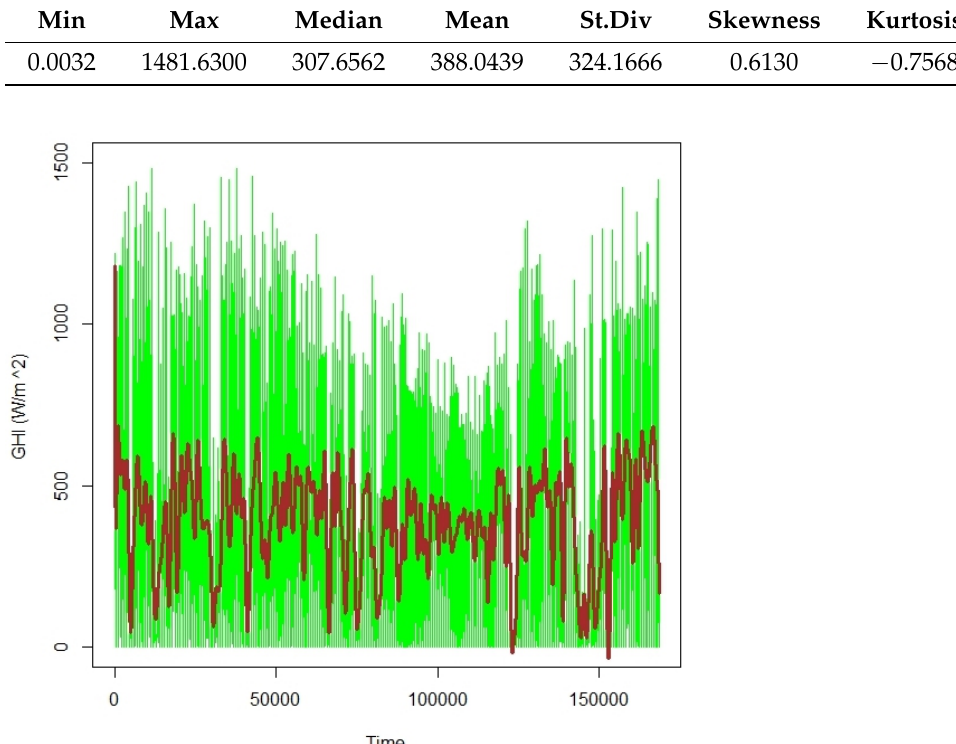
Figure 2. Time series plot of GHI, Density plot, Quantile-Quantile(qq) plot, and Box and whisker plot. Table 3. The descriptive statistics of the GHI measured in W/m 2 .